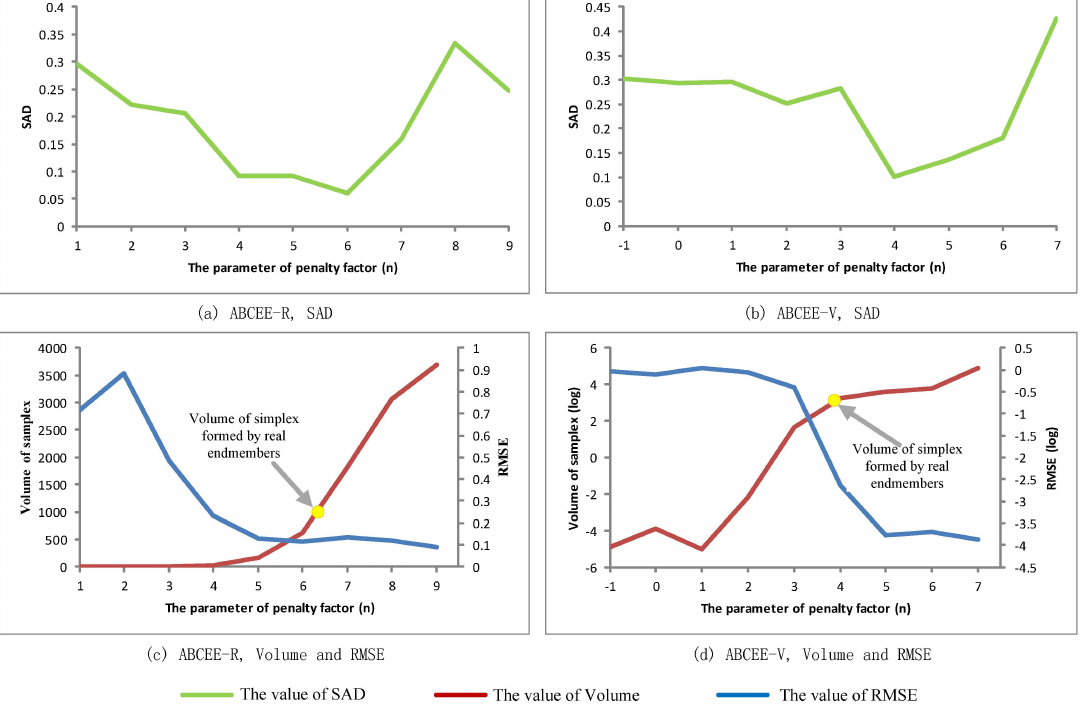
Figure 4. Influence of the penalty factors µ R and µ V ( a ) the SAD of ABCEE-R; ( b ) the SAD of ABCEE-V; ( c ) the Volume and RMSE of ABCEE-R; ( d ) the Volume and RMSE of